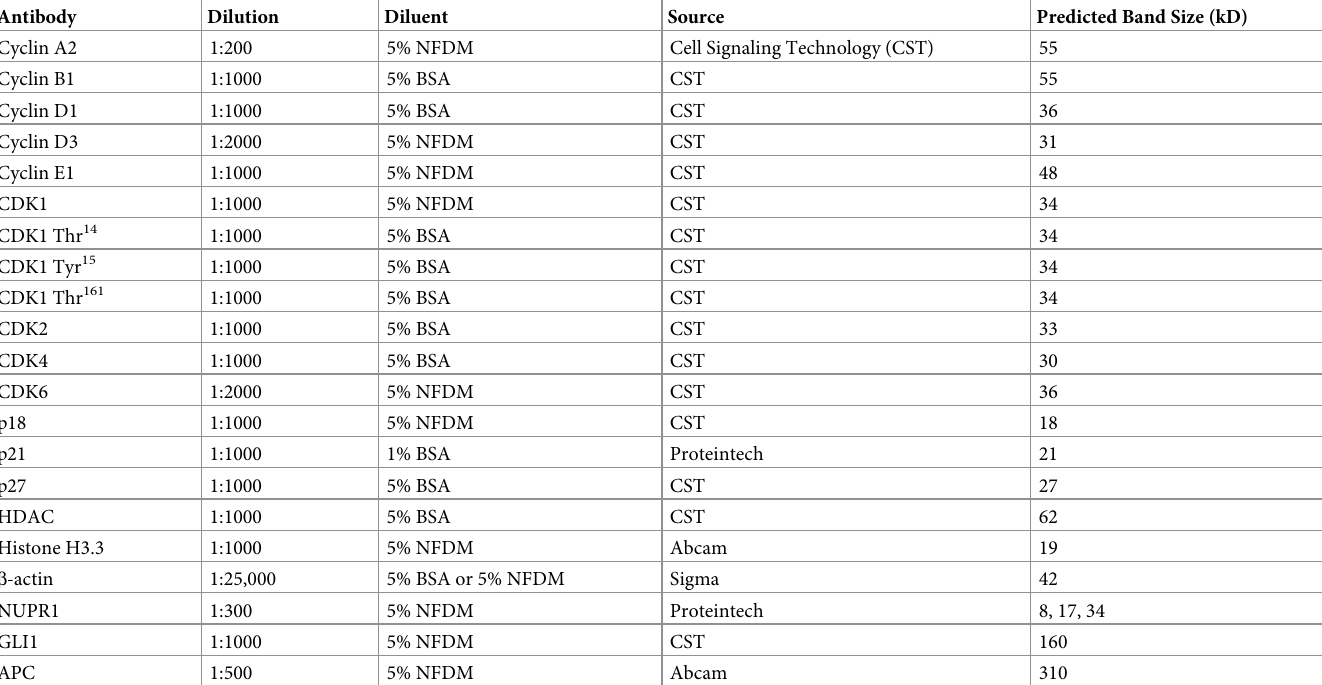
Table 1. Antibody information for western